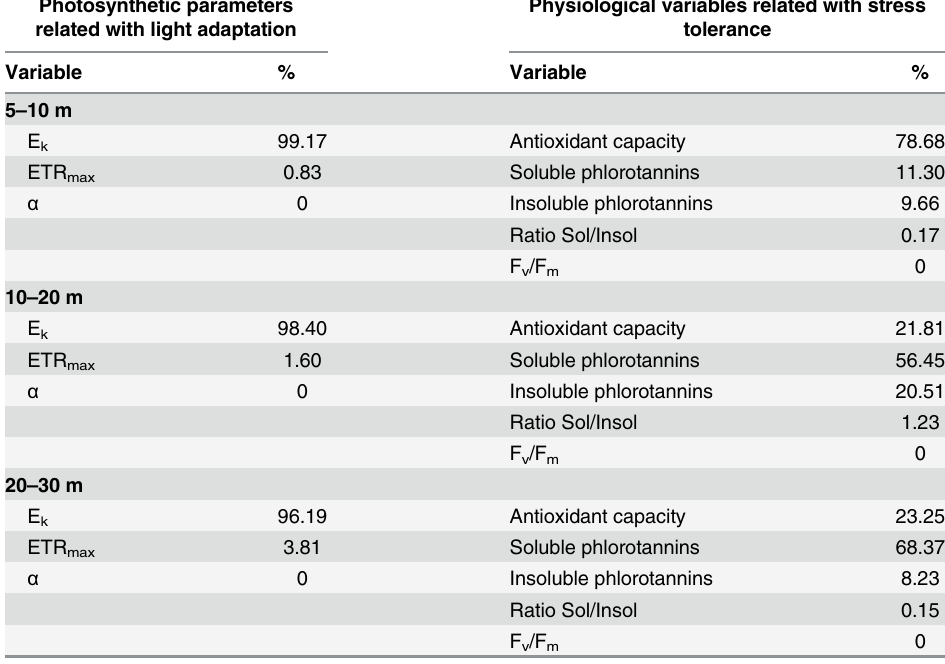
Table 1. SIMPER analysis of different photosynthetic and biochemical variables measured in four Antarctic brown algae that contribute to the dissimilarity across different depth strata. Photosynthetic parameters: maximal photosynthesis measured as ETR values; saturation irradiance for photosynthesis (E k ); maximum electron transport rate (ETR max ); initial slope of the ETR-I curve ( α ); maximum quantum yield (F v /F m ).